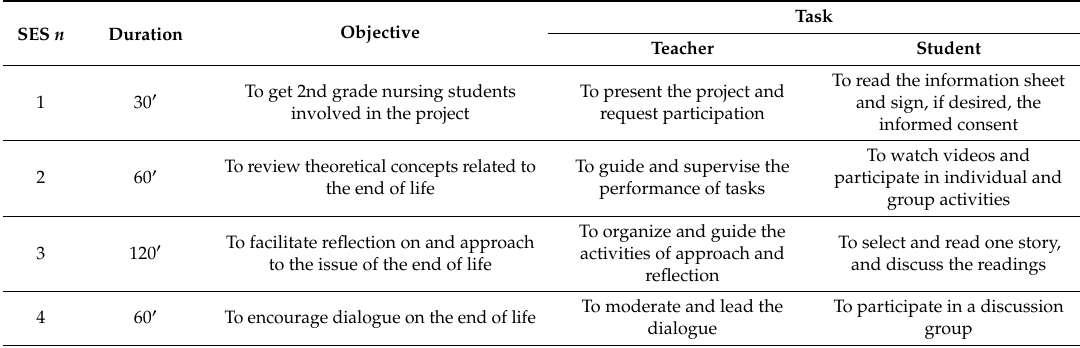
Table 1. Sessions of the innovation project (number, duration and tasks) with an indication of the main actor (teacher /